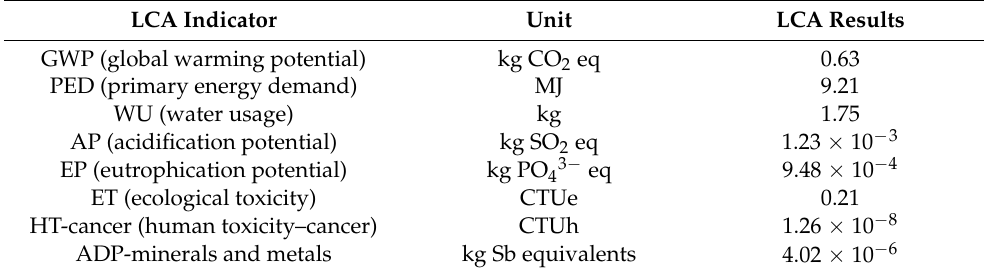
Table 3. Results for scenario 1.